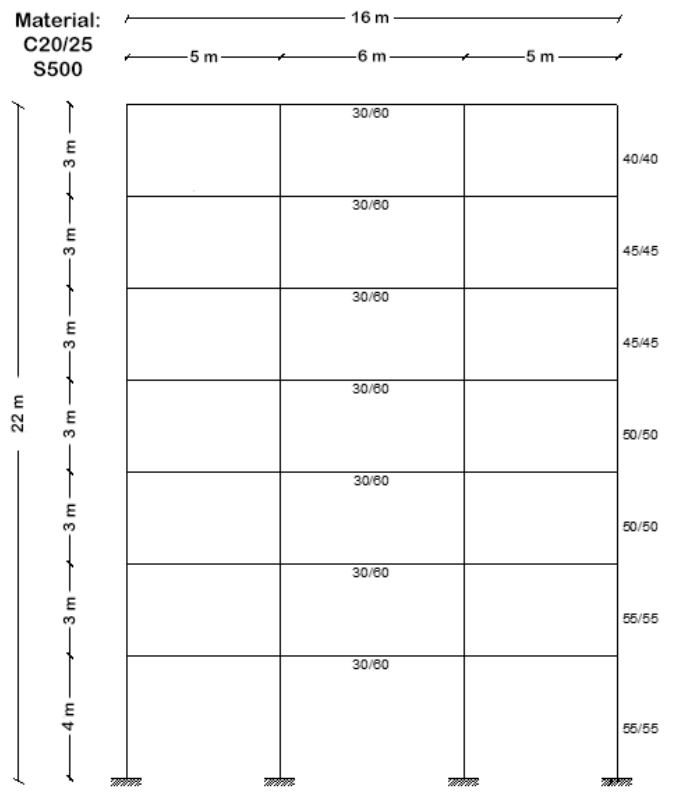
Figure 4. Reinforced concrete frame.